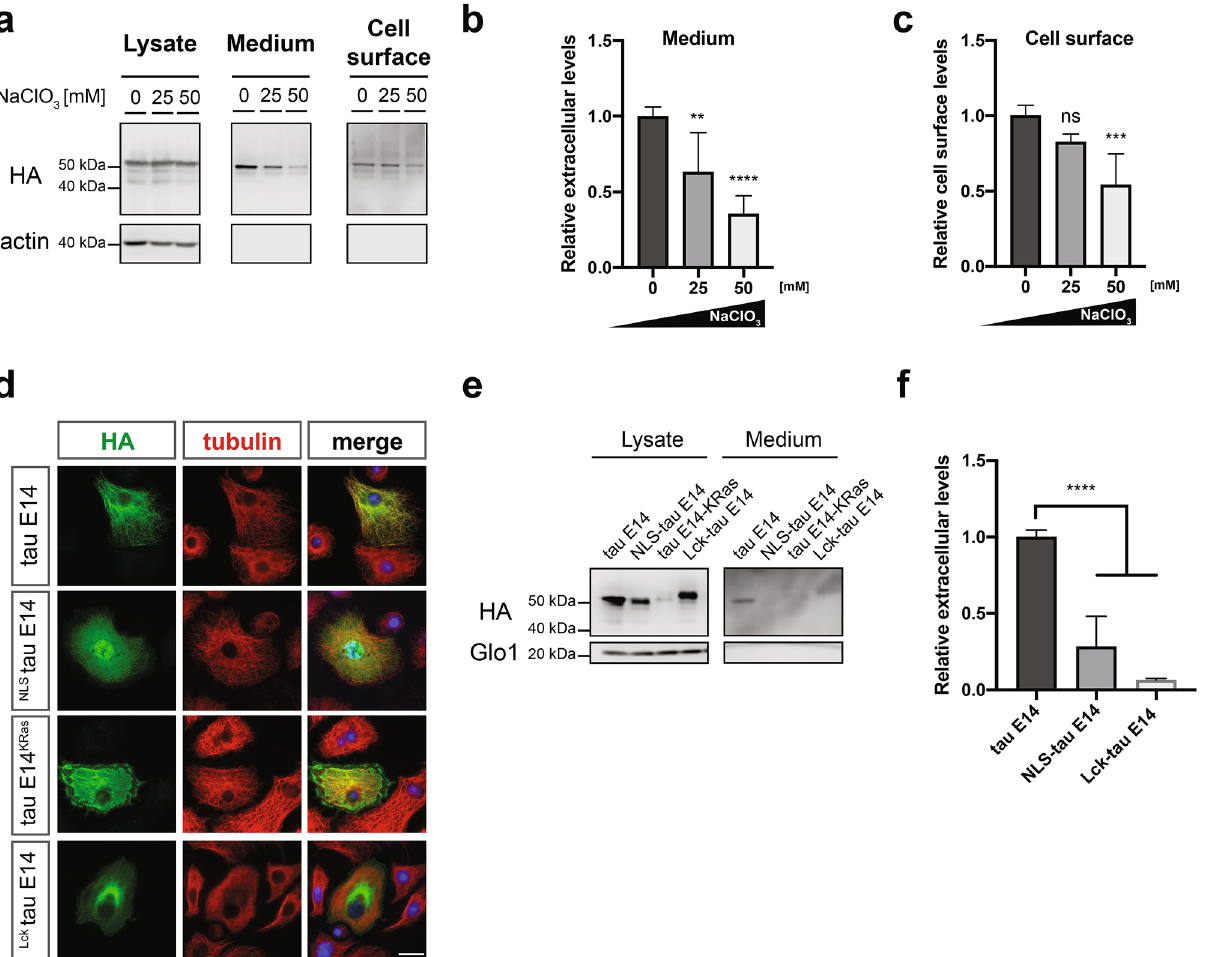
Figure 4. Type I unconventional secretion of tau depends on the presence of functional sulfated proteoglycans. (a) Tau E14-expressing cells were treated with increasing concentrations of NaClO 3 and upon collection of the conditioned media, the living cells were incubated with Heparin to retrieve the surface-bound proteins prior to cell lysis. Both medium and Heparin fractions were subjected to immunoprecipitation and were immunoblotted together with lysates against HA and actin. (b,c) Secreted and surface-associated fractions were densitometrically quantified, normalized to the intracellular levels, and then compared to the untreated control. The data represent mean values ± s.d. derived from n = 7 biological replicates for the medium and n = 5 for the Heparin data. Statistical analysis was performed through one-way ANOVA and followed by Tukey’s post hoc test. (d) Cells expressing tau E14 with and without cellular localization signals were stained against HA and tubulin, whereas Hoechst was used for nuclear staining (scale bar, 15 µm). (e,f) Cell lysates and immunoprecipitated media from cells expressing the tau E14 variants were immunoblotted against HA and Glo1. The densitometrically quantified secreted tau was initially normalized to the intracellular levels and then compared to the original tau E14 variant. The data represent mean values ± s.d. derived from at least 3 biological replicates and were subjected to one-way ANOVA, followed by Tukey’s post hoc